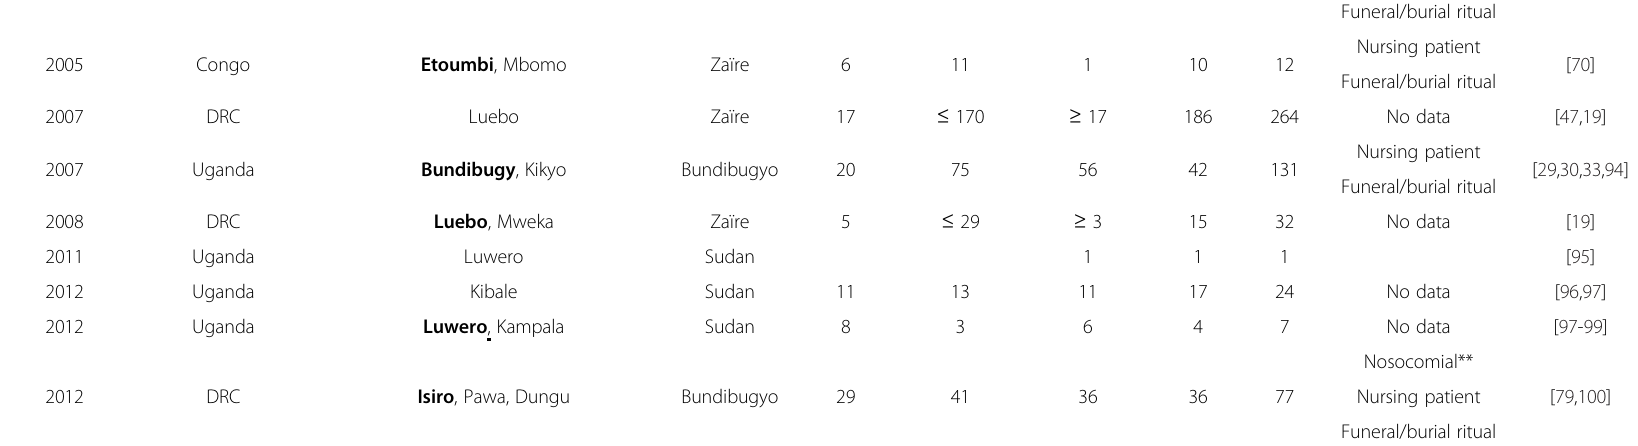
Table 4 Characteristics of the African manifestations of Ebola virus (bolded names indicate the place of first case occurrence) (Continued)